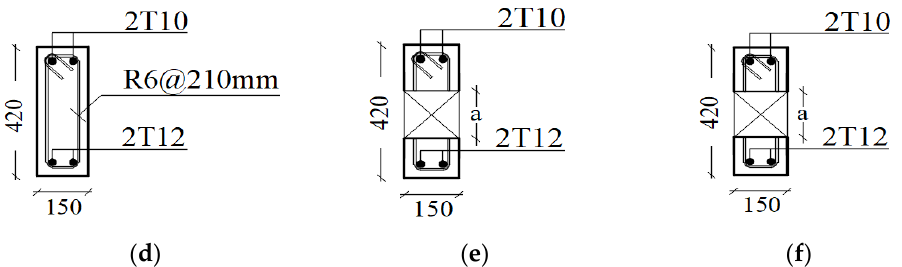
Figure 1. Experimental Sample Dimensions; ( a ) control beam; ( b ) opening in tension zone; ( c ) opening in the shear zone; ( d ) cross section ① - ① ; ( e ) cross section ② - ② ; ( f ) cross section ③ - ③ (dimensions are in mm).